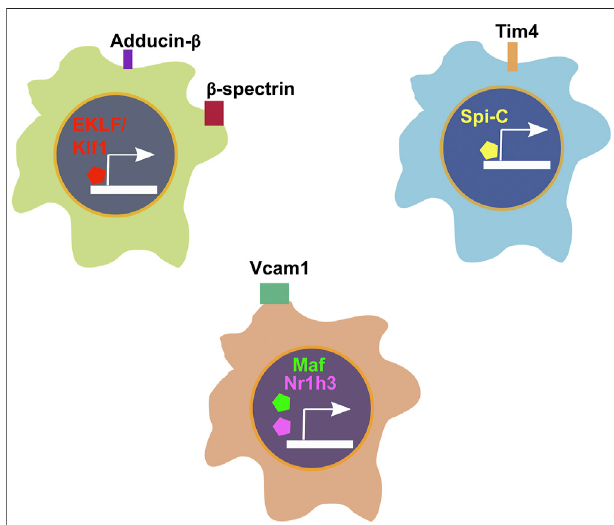
FIGURE 5 | Summary of transcription factors and corresponding cell surface markers associated with cellular heterogeneity in E13.5 FL